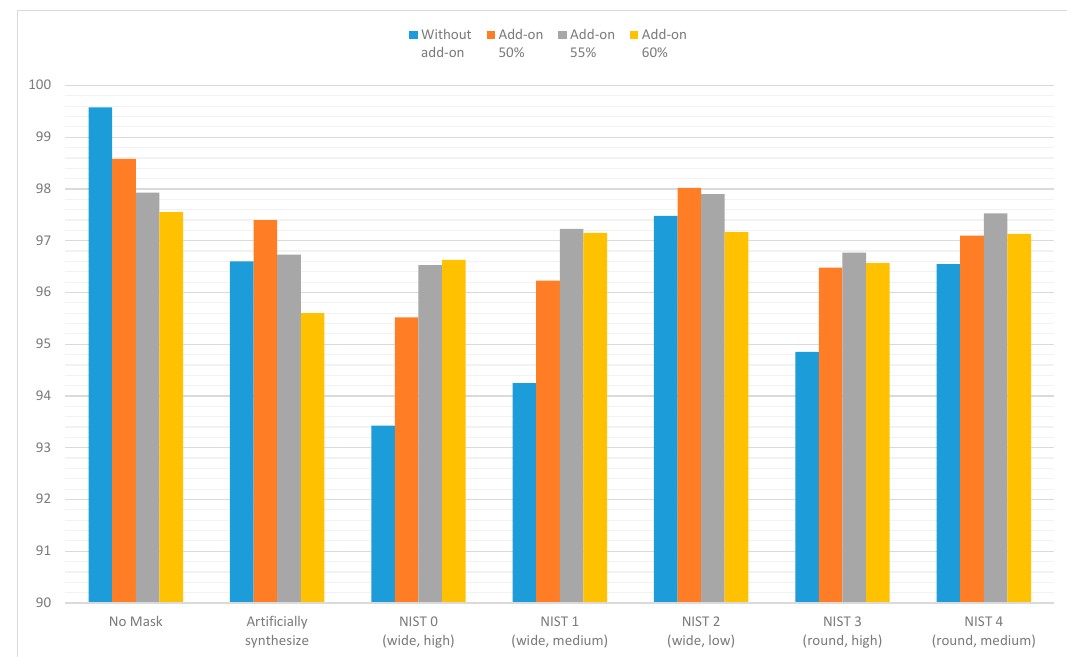
Figure 9. Performance graphs according to test cases. Table 1. Performance comparison results of the proposed